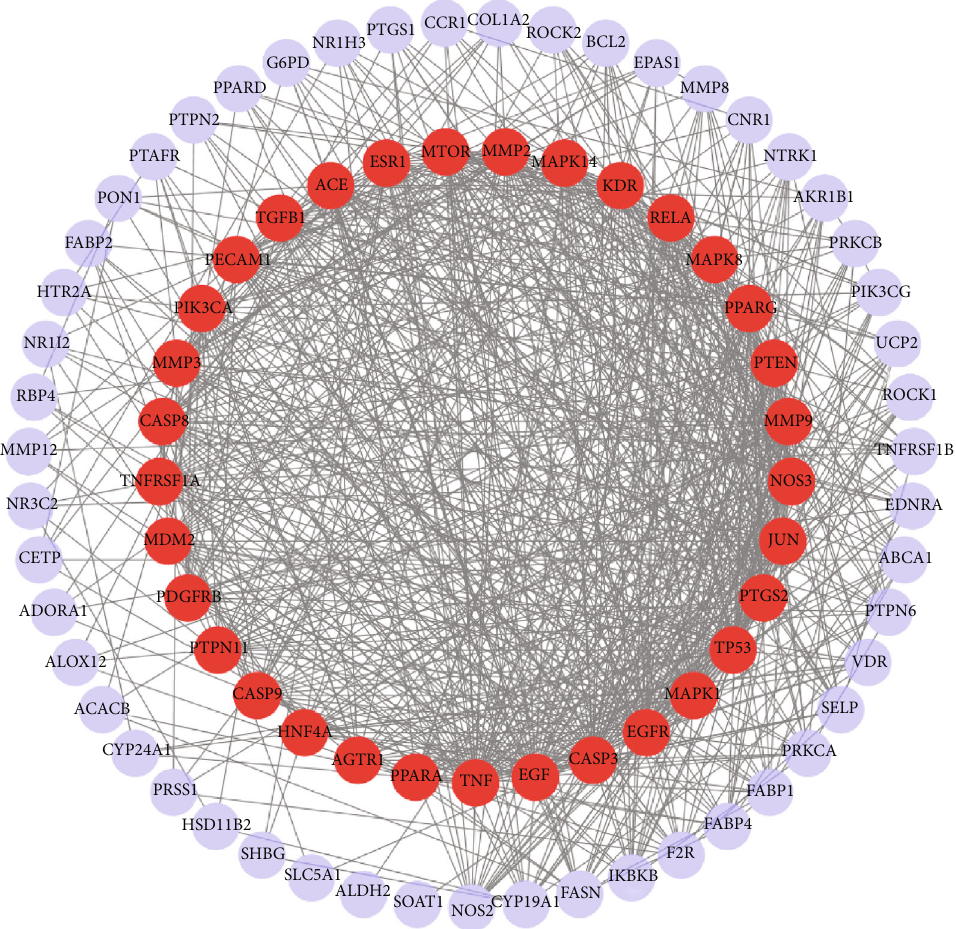
Figure 5: PPI network integration and analysis. The red nodes display the most potential targets in treating DN, which are greater than the average degree. Also, the nodes in purple show the potential targets under the average degree. Furthermore, the density of lines among inner nodes indicates the interaction relationship between di ff erent protein